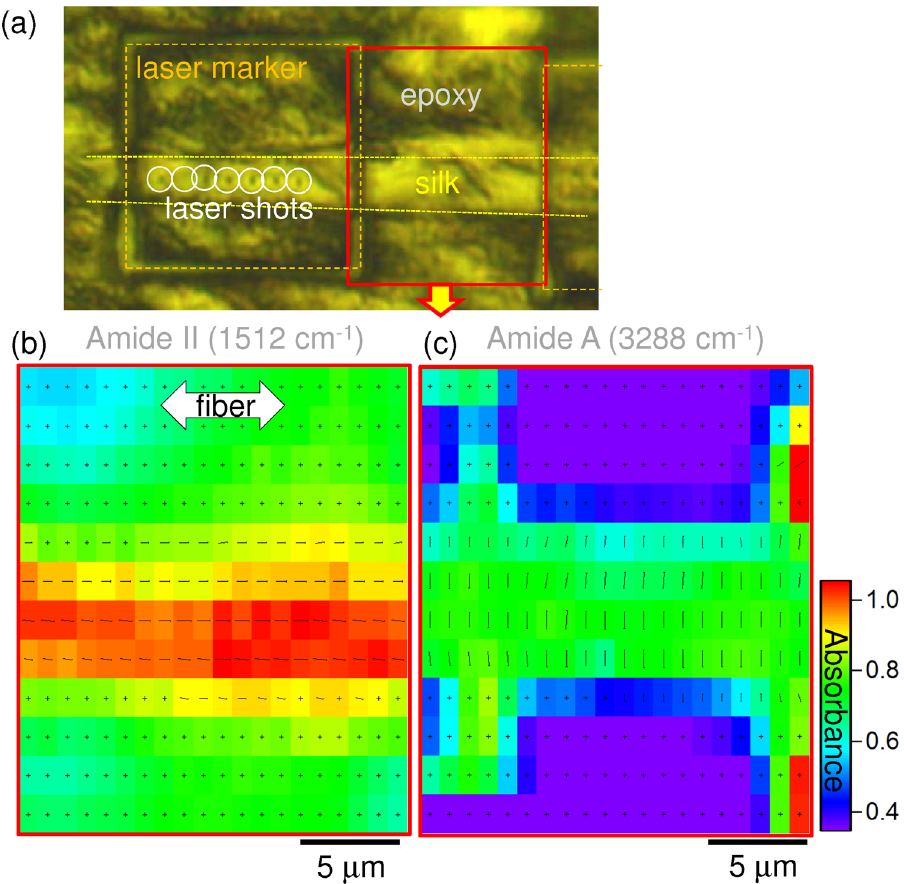
Figure 4. ( a ) An optical image of the L cross section of a Bombyx mori silk fiber with laser marked 20 × 20 μ m 2 regions and laser irradiated spots. The region mapped in ( b , c ) is shown in a solid rectangle in ( a ). ( b , c ) Orientation vector map (marker’s length Eqn. 1 and orientation Eqn. 2) overlayed with the far-field absorbance (color map) at the C-N ( b ) and N-H ( c ) bands; these bonds are known to be perpendicular. S-polarised incident light was perpendicular to the fiber; in the plane of